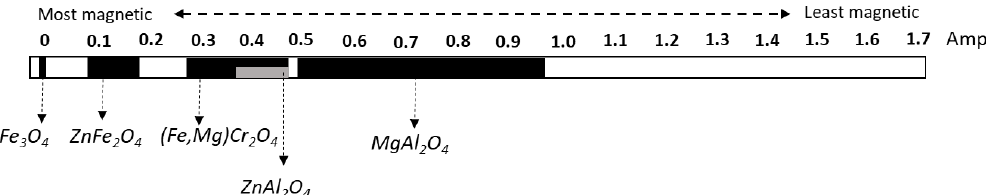
ff erent spinel structures